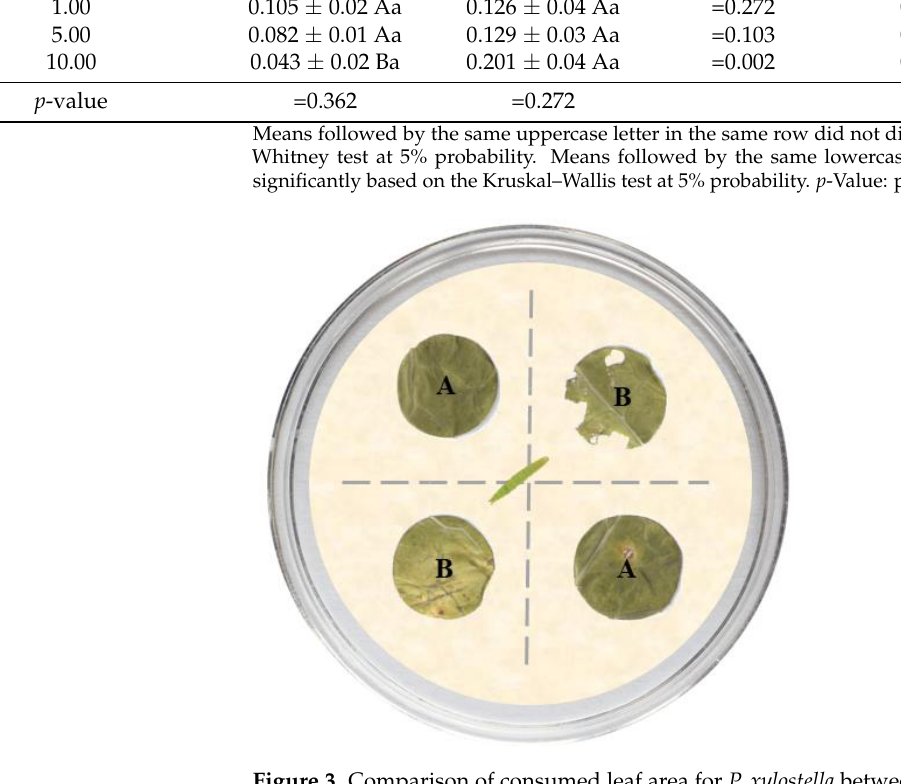
Means followed by the same lowercase letter (in the column) and same uppercase letter (in the same row) did not differ significantly in the contrasts from the quasipoisson model at 5% probability. p - Value: probability value. From the first day of observation, the adults preferred collard green discs without the extract for laying (Figure 4). Females exposed to the extracts at 10% concentration had a reduced oviposition period (last egg laying at 120 h) compared with those exposed to the concentrations of 5% and 1% (last egg laying at 240 h) (Figure 4). In general, females exposed to the 10% concentration suffered a premature death, which was not observed for males.